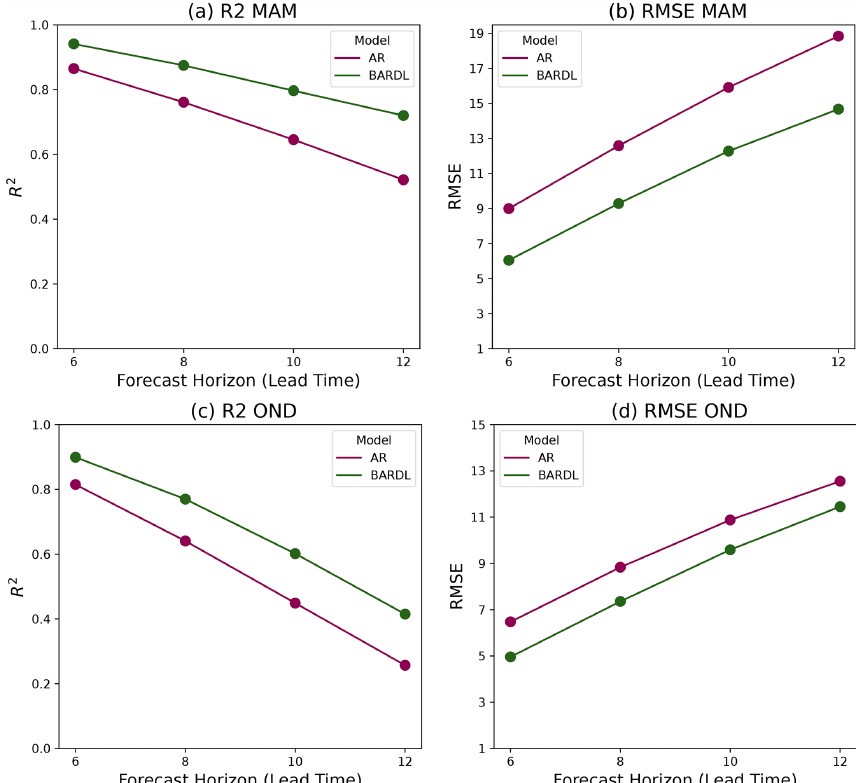
Figure 6. Performance metrics used to measure model accuracy as a function of forecast lead time for MAM and OND